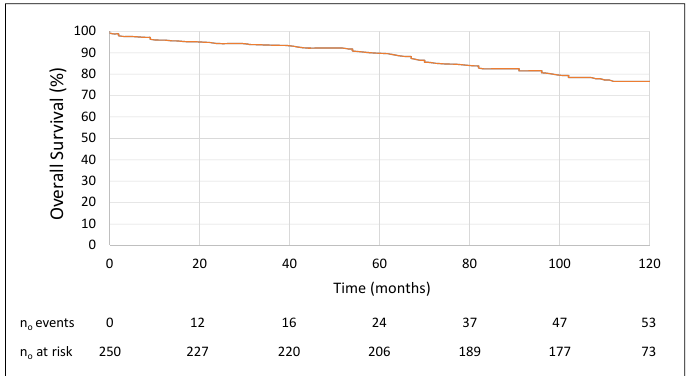
Figure 1. Overal Survival Curve (Kaplan ‐ Meier method model).